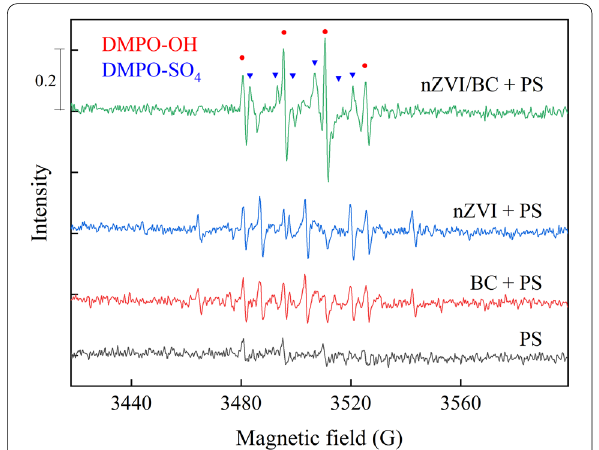
Fig. 4 EPR spectrum in different treatment solutions. DMPO: 0.1 mol/L; PS: 0.5 mmol L − 1 ; BC: 0.05 g L − 1 ; nZVI: 0.05 g L − 1 ; nZVI/BC: · 0.1 g L −